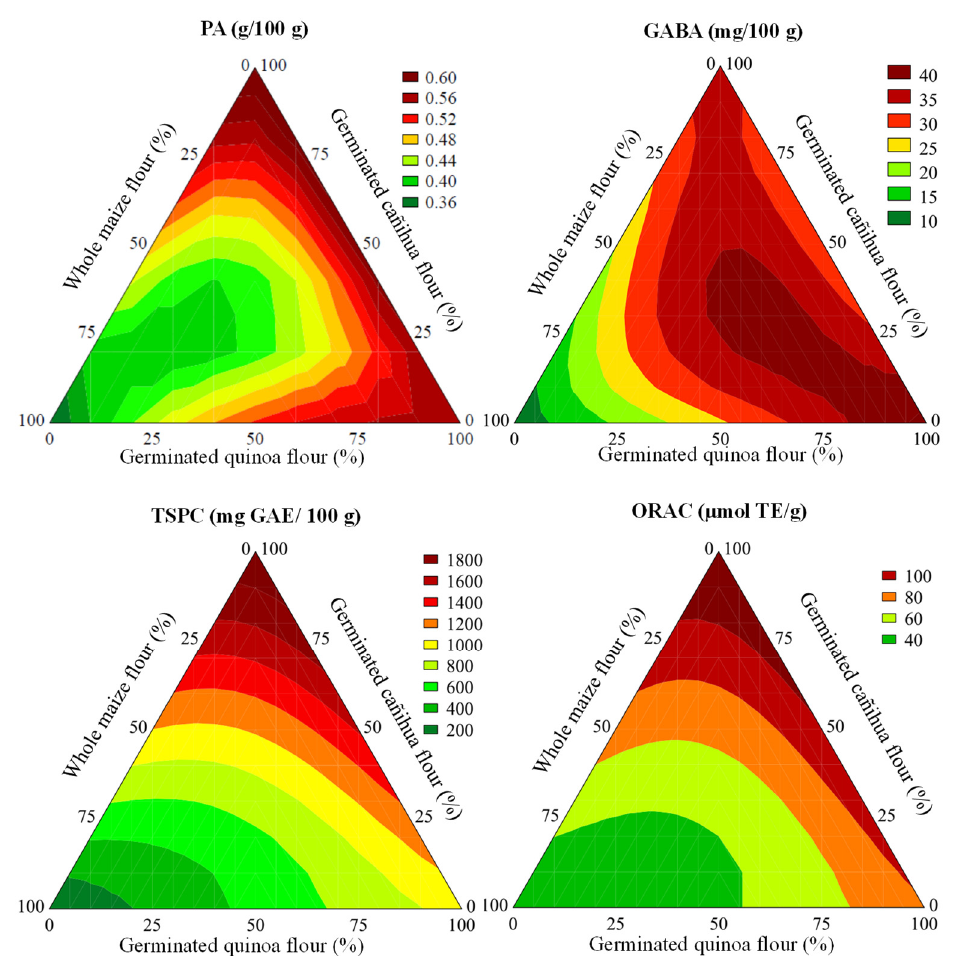
Figure 2. Contour plots of predicted phytic acid (PA), γ -aminobutyric acid (GABA), total soluble phenolic compounds (TSPC) and oxygen radical absorbance capacity (ORAC) in extrudates elaborated with different ratios of CG, SQF and SCF.